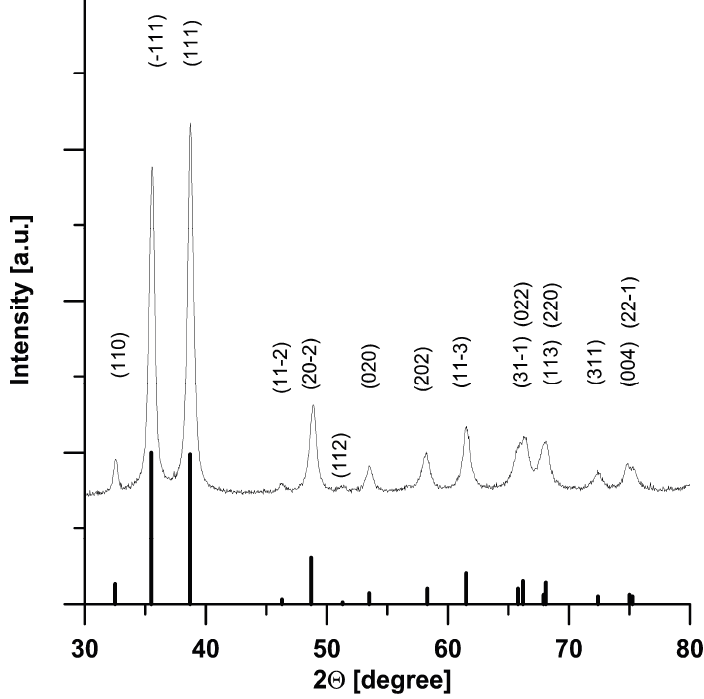
Figure 5. TEM image of CuO prepared at optimized conditions (Table 1, sample 8).